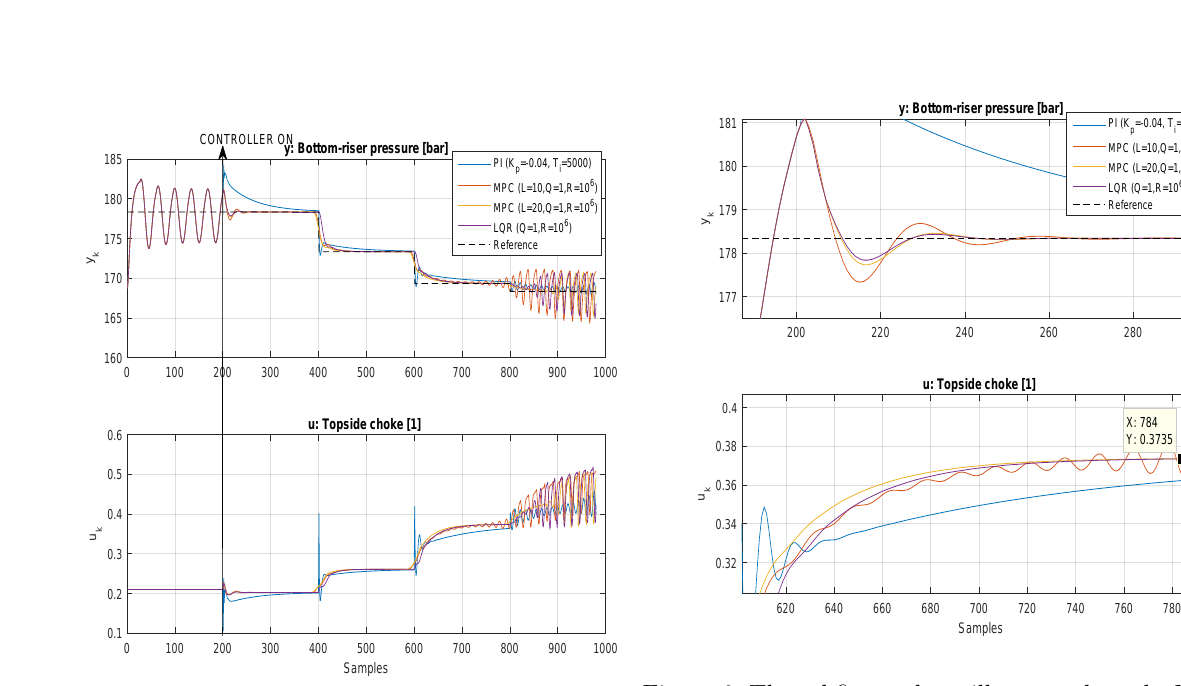
Figure 5: Four controllers, based @0.15, are imple- mented on the real process (Di Meglio) turned on from starting point k = 200. We are comparing LQR, MPC (L=10), MPC (L=20) and PI. The PI controller is tuned using MATLAB Tuner Application. The weights for MPC and LQR are chosen to be the same values. Sampling time is 100 sec.